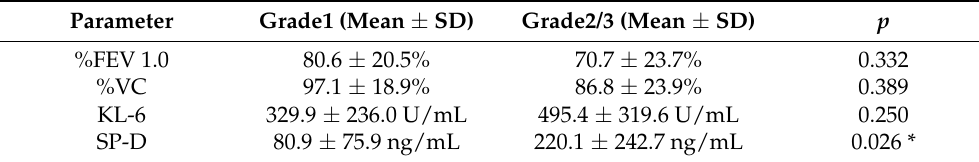
Table 4. The correlation between pretreatment clinical factors and radiation pneumonitis.